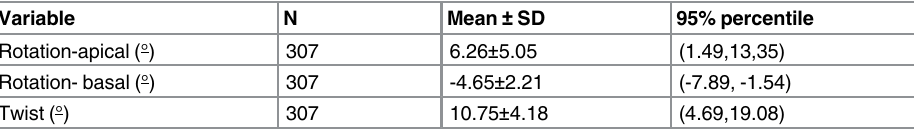
Table 4. Normal ranges of LV twist and rotation of study